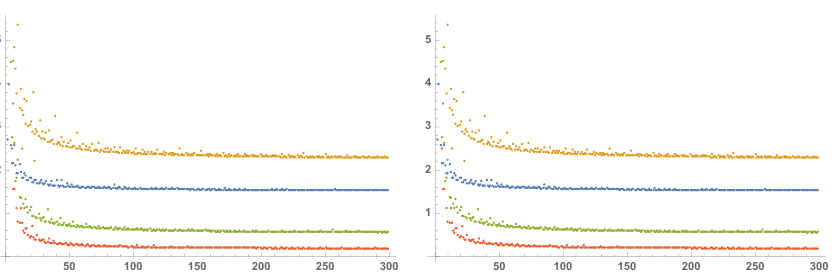
Figure 6. Asymptotic behavior of the sequence approximating the radius of convergence r n for a 0 = a 1 = − 1 (on the left ) and a 0 = a 1 = 1 (on the right ) with β = 1/2, u 0 = 1/3 and p = 1,2,3 in blue, orange, and green, respectively.